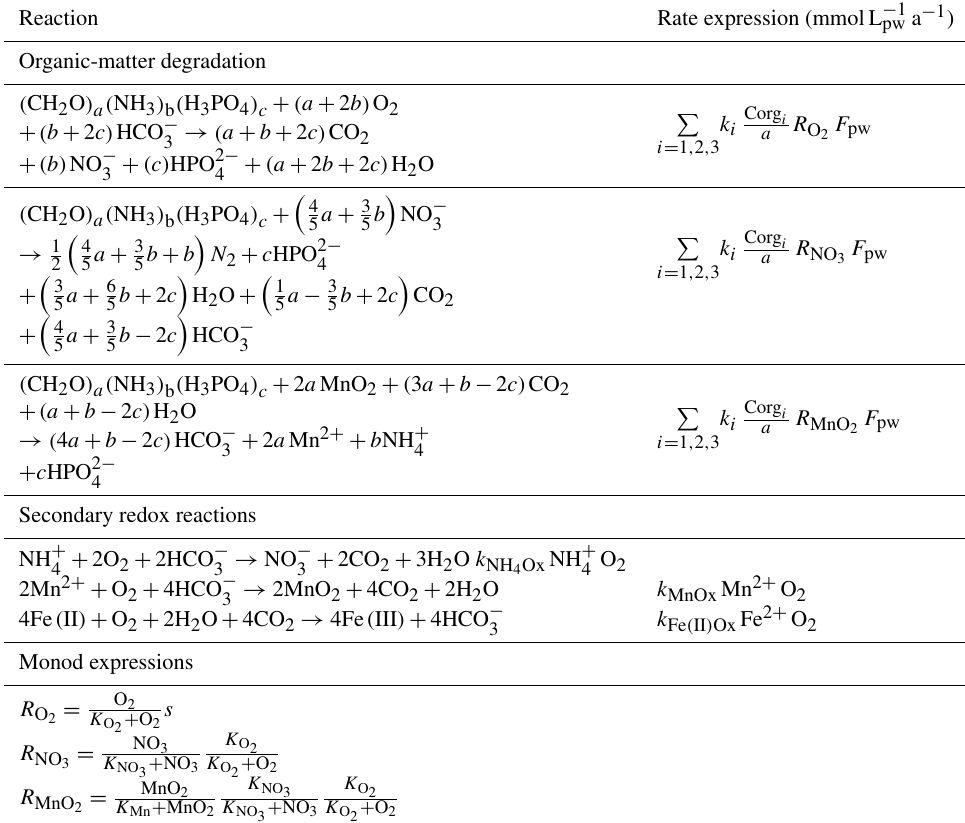
(cid:16) 1 − φ (cid:17) φ